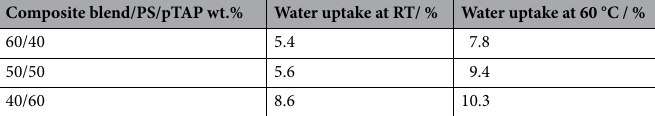
Table 1. Water uptake for the fabricated PS/pTAP composite membranes.